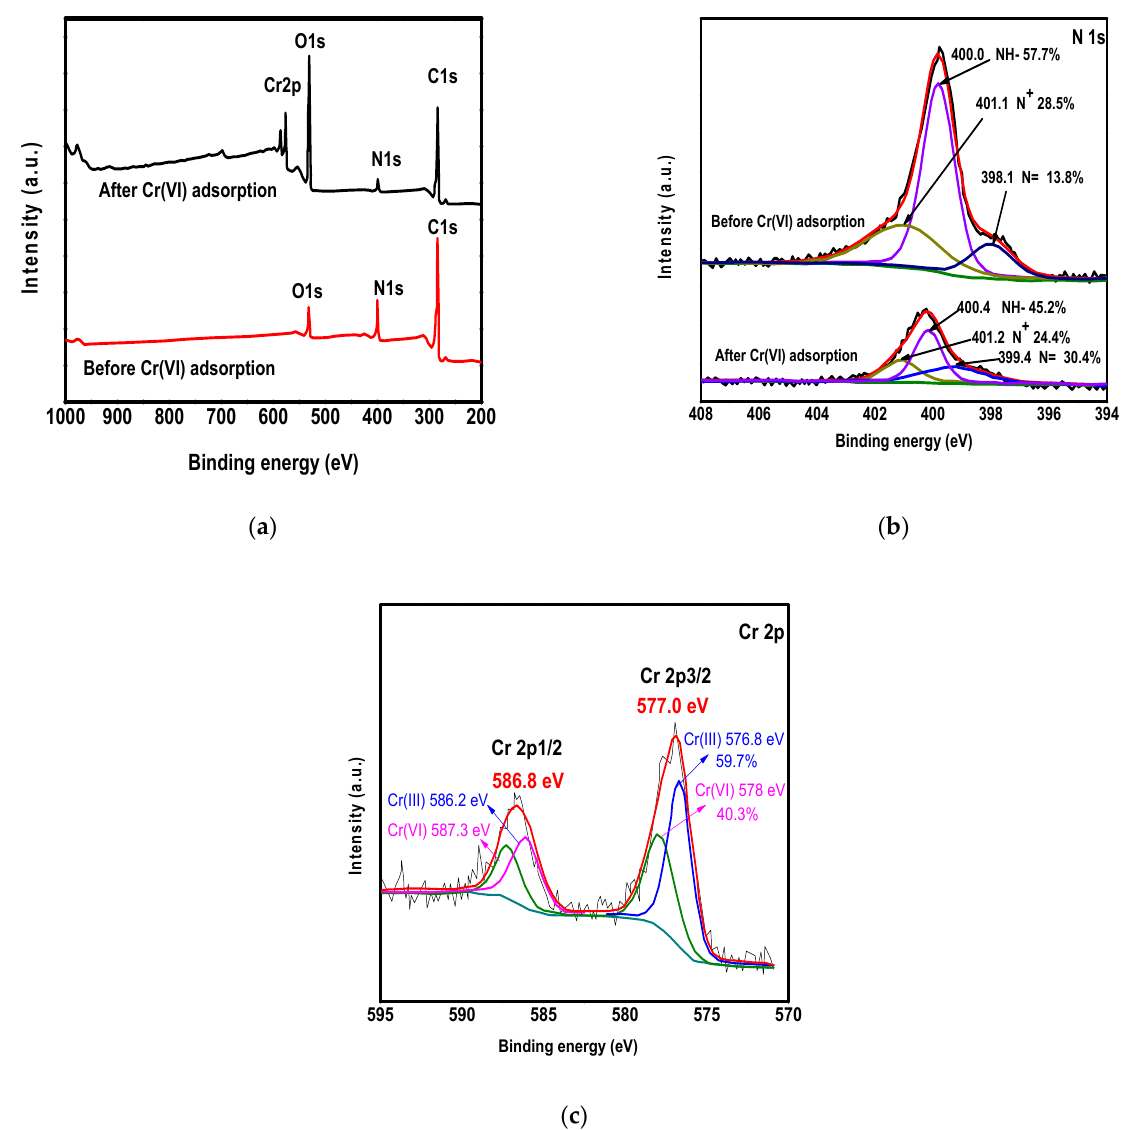
Figure 7. XPS spectra of ppy/NC nanocomposite with survey scan ( a ), N 1s spectra ( b ), and ( c ) Cr 2p spectra before and after adsorption process.